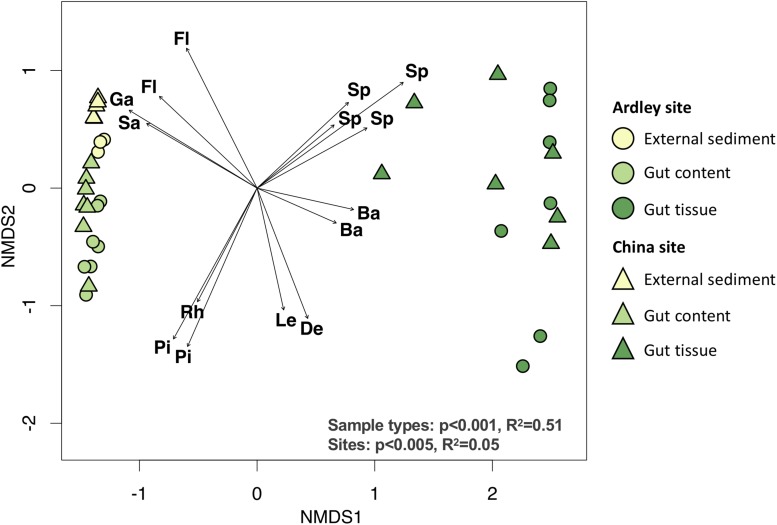
Non-metric multidimensional scaling ordination of the bacterial community composition of the Abatus agassizii gut and external sediment microbiota. Colors are assigned to the different sample types. Circles and triangles represent samples from Ardley and China sites, respectively. The arrows represent the variations of the 15 discriminant OTUs most significantly correlated with community ordination (envfit, p < 0.05). The letters indicate the taxonomic identification at the family level of the discriminant OTUs (Ba: Bacteroidetes BD2-2, De: Desulfobacteraceae, Fl: Flavobacteriaceae, Ga: Gammaproteobacteria unclassified, Le: Lentimicrobiaceae, Pi: Pirullulaceae, Rh: Rhodobacteraceae, Sa: Sandaracinaceae, Sp: Spirochaetaceae). Effect of the sample type and the site was tested using permutational multivariate analysis of variance (Adonis test) on Bray–Curtis distance matrix computed from the OTU table (details provided in Supplementary Table S2).